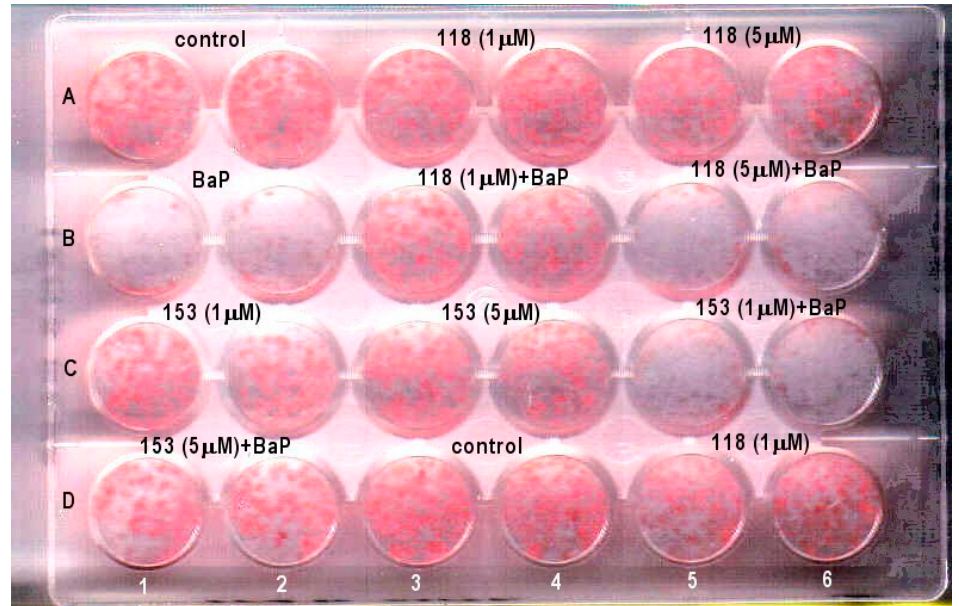
Figure A1. Effects of PCB118, PCB153 and BaP on “Oil Red O” staining of adipocytes in Time 1 conditions. 3T3-L1 cells were incubated with or without PCB118 (one or five micromolars) or PCB153 (one or five micromolars) in the presence or not of BaP (one micromolar) according to the “Time 1” or “Time 2” conditions described in materials and methods. The measurement of cellular lipids was carried out using the “Oil Red O” staining method as described under materials and methods.